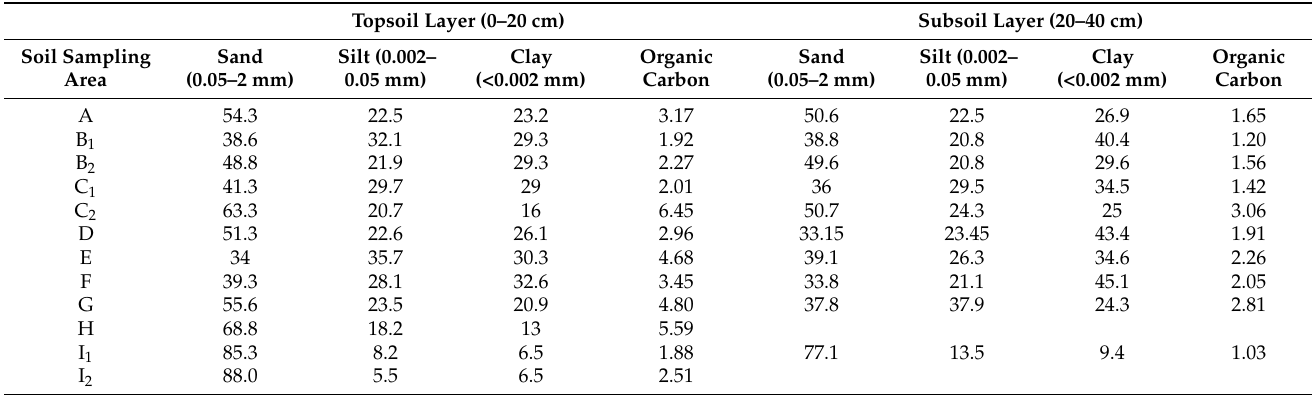
Table 1. Soil physical and chemical properties of different altitude zones in the Yinna mountainous area (%).